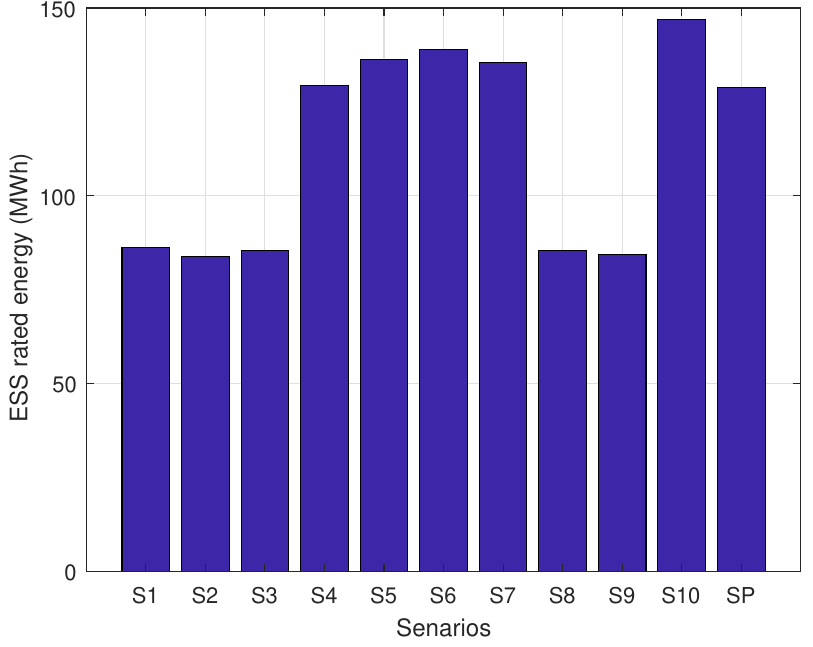
Figure 18. ESS rated energy of all